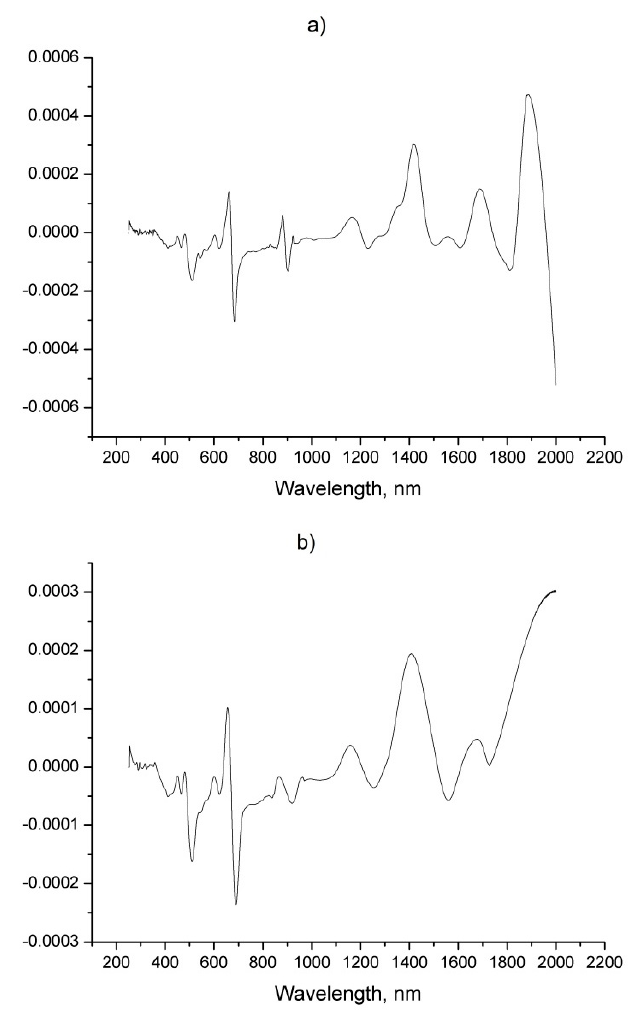
Figure 4. First derivative spectra obtained with SBSF (step-by-step filter) method: ( a ) 2-points; ( b ) 5 points filter window.